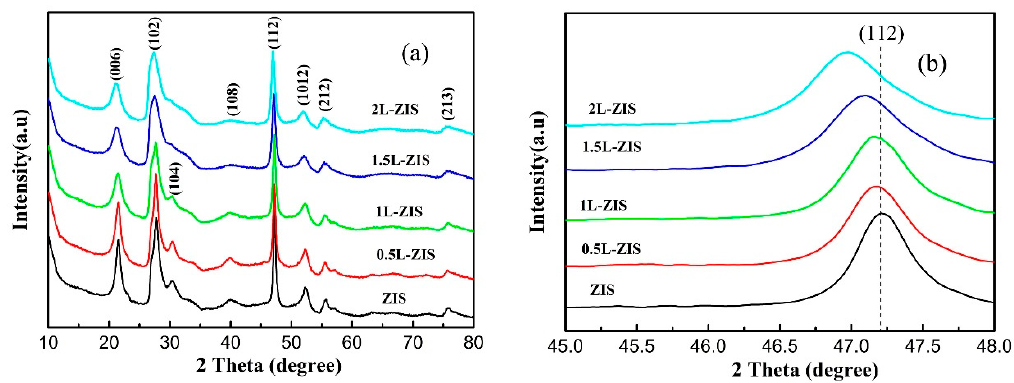
Figure 1. ( a ) X–ray diffractometer (XRD) patterns of Pure ZnIn 2 S 4 (P-ZIS) and doped ZnIn 2 S 4 (ZIS) samples; ( b ) partially enlarged diffraction peak of (112) plane of P-ZIS and doped ZIS samples.